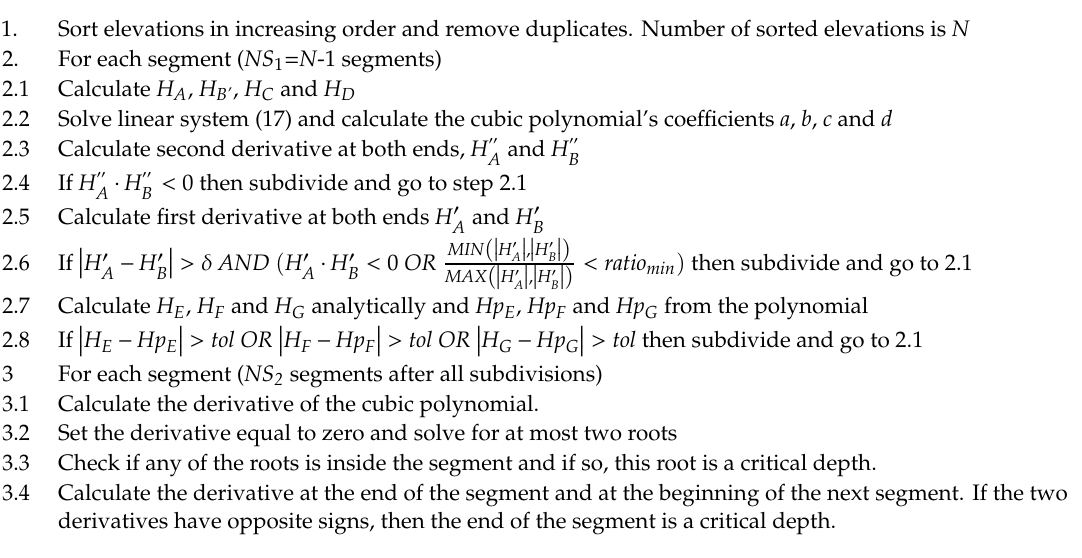
Table 1. Outline of Adaptive Cubic Polynomial Algorithm